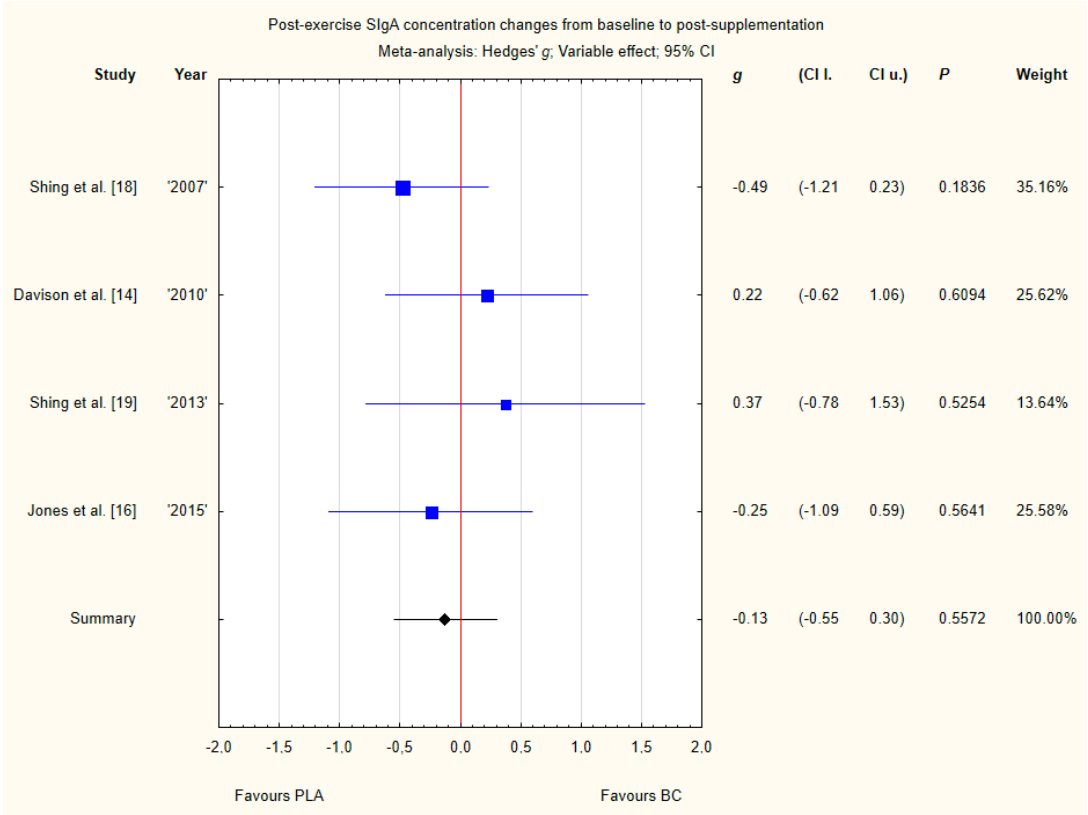
Figure 11. Forest plot of the random-effects meta-analysis of changes from baseline to post-supplementation in post-exercise SIgA concentration. Heterogeneity: Tau 2 = 0; Chi 2 = 2.42; df = 3; I 2 = 0%; P = 0.4898. Abbreviations: BC–bovine colostrum, SIgA–secretory Immunoglobulin A, PLA–placebo.